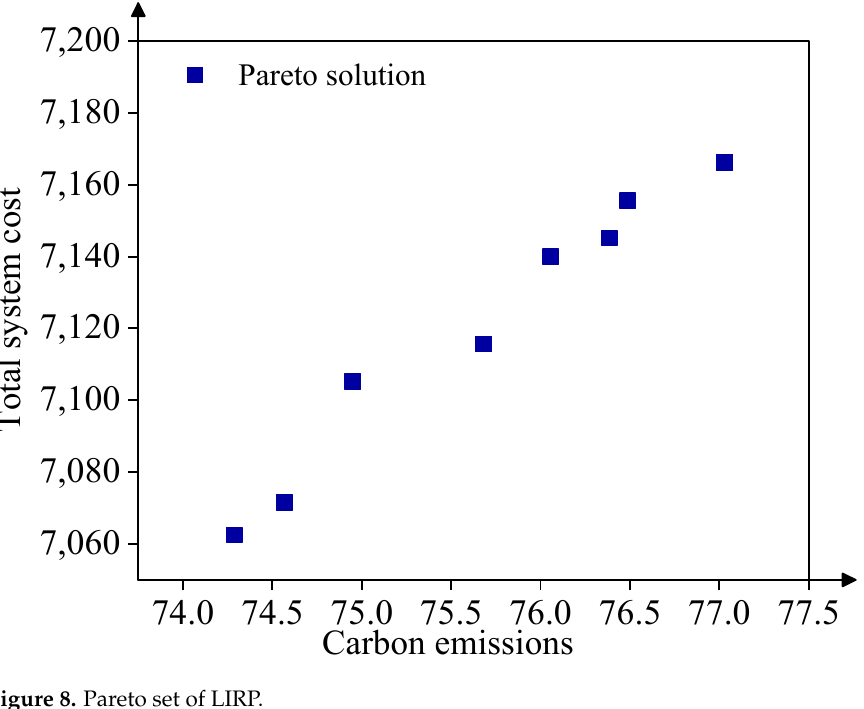
Figure 8. Pareto set of LIRP.